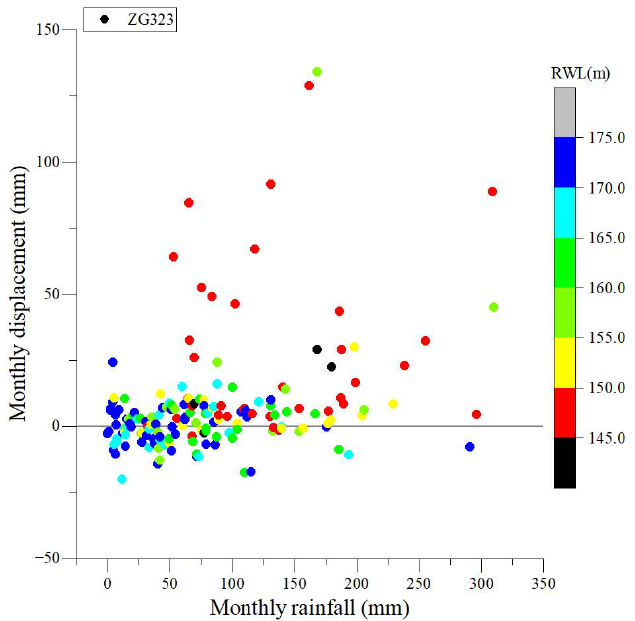
Figure 17. Effect of Rainfall on landslide displacement illustrated by ZG323.